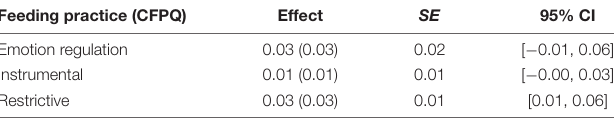
TABLE 3 | Results for parallel indirect effects of parental feeding practices ( N = 410).